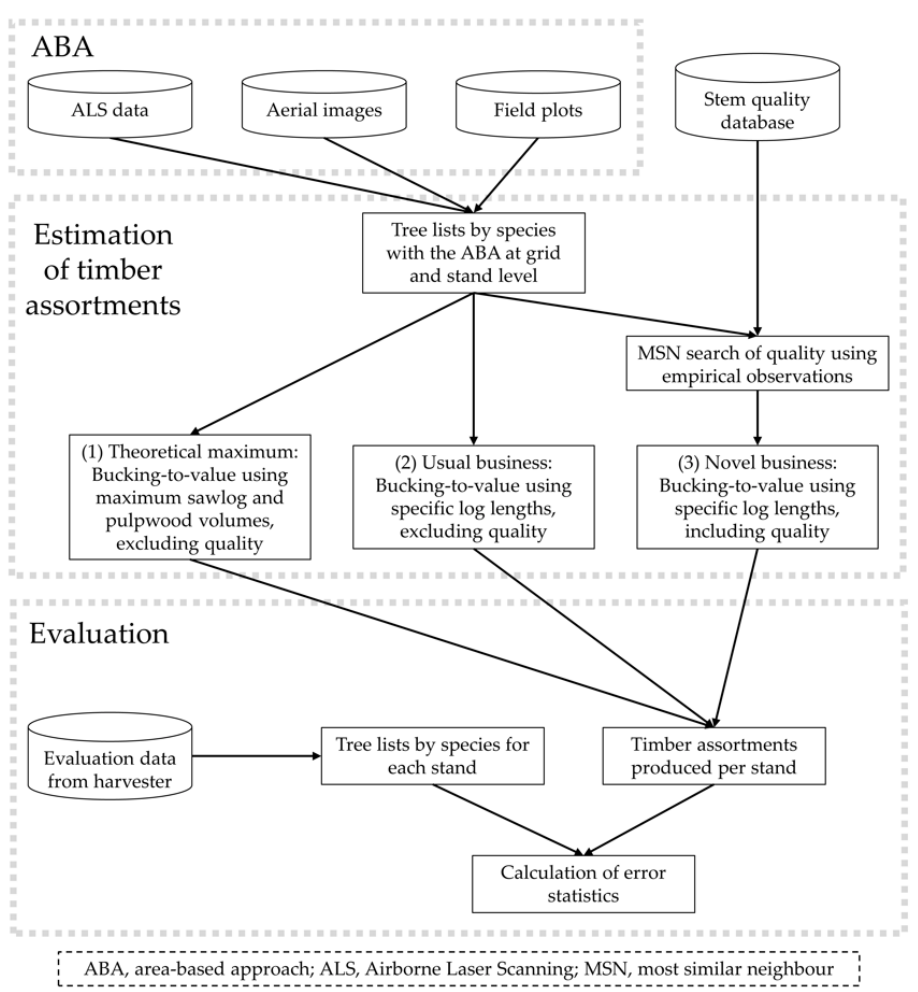
Figure 2. Flowchart of the methodology followed to obtain the timber assortments and error statistics.